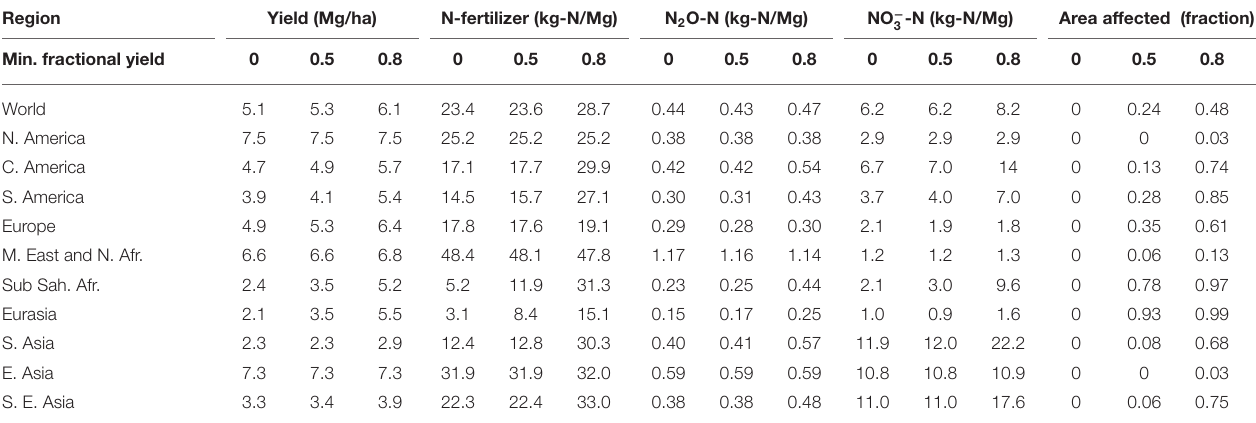
TABLE 2 | The effect of following the “minimum fractional yield” pathway on maize yields, yield-scaled N-fertilizer usage, yield-scaled N 2 O emissions (direct and indirect) and yield-scaled NO − 3